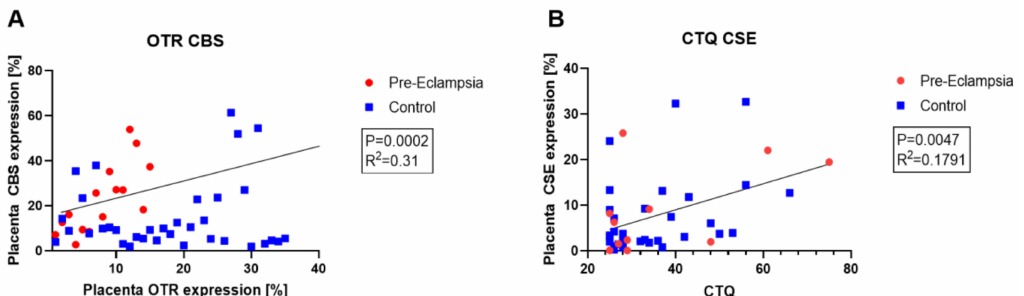
Figure 4. Preliminary results of the NU-HOPE observational trial. ( A ): Placental expression of the H 2 S-producting enzyme cystathionine- β -synthase (CBS) and oxytocin receptor (OTR) directly correlate. ( B ): The childhood trauma questionnaire score (CTQ) directly correlates with placental expression of the H 2 S-producing enzyme cystathionine- γ -lyase